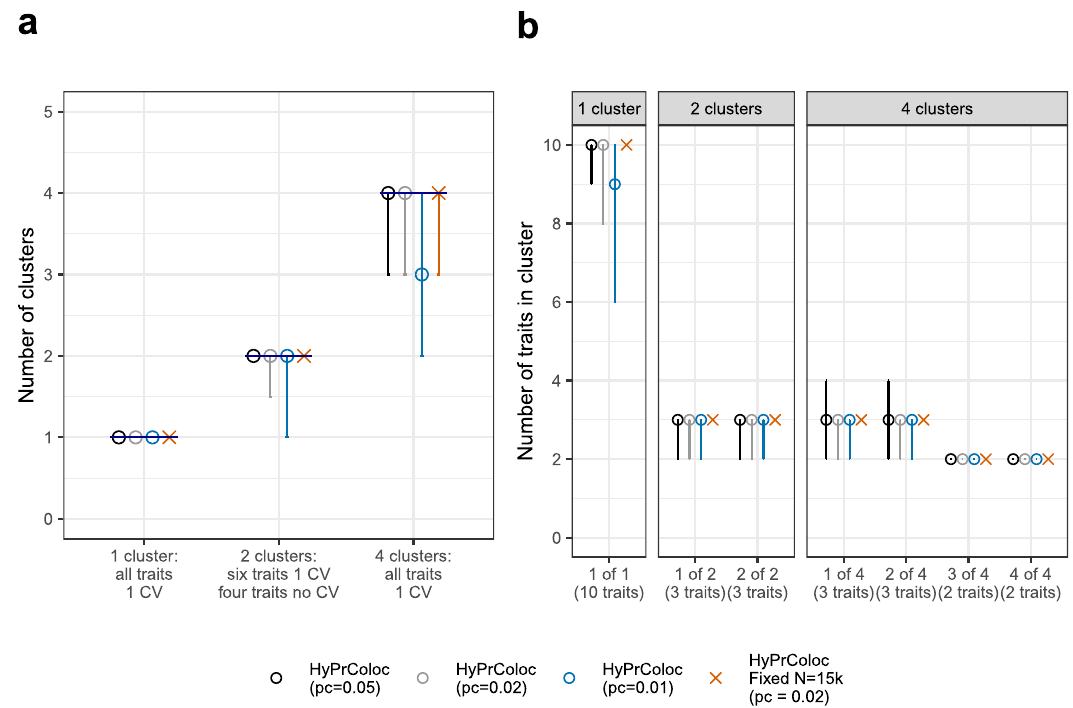
Fig. 5 Number of clusters of colocalized traits and number of traits within a cluster. Results from the single causal variant simulation study (c.f. Supplementary Fig. S2), presenting a the number of clusters of colocalized traits; and b the number of traits within each cluster identi fi ed by HyPrColoc. Error bars denote the 1st and 9th deciles and a point denotes the median